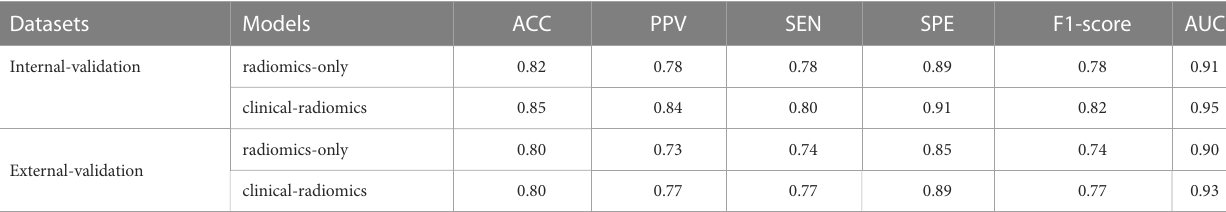
TABLE 3 Performance of SRS ef fi cacy prediction models in internal and external validation sets.